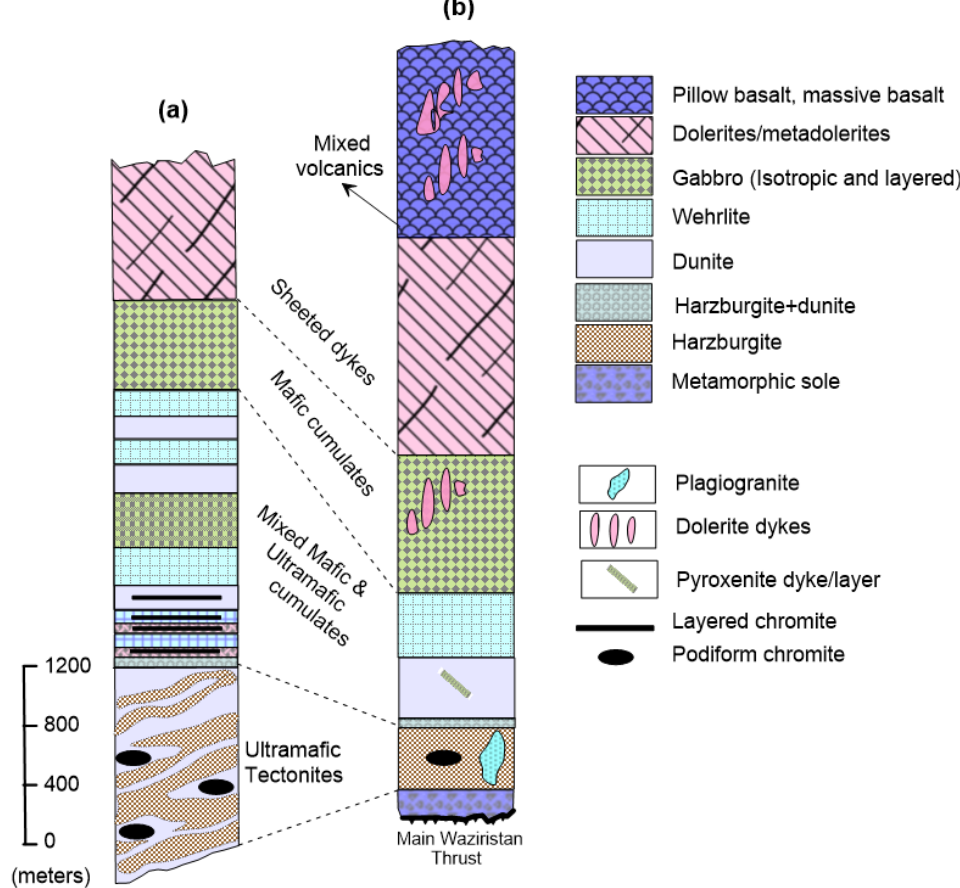
Figure 1. Geological sections. ( a ) Muslim Bagh ophiolite (redrawn after Siddiqui et al. [40]); ( b ) Waziristan Ophiolite complex (modified after Khan [25] ).